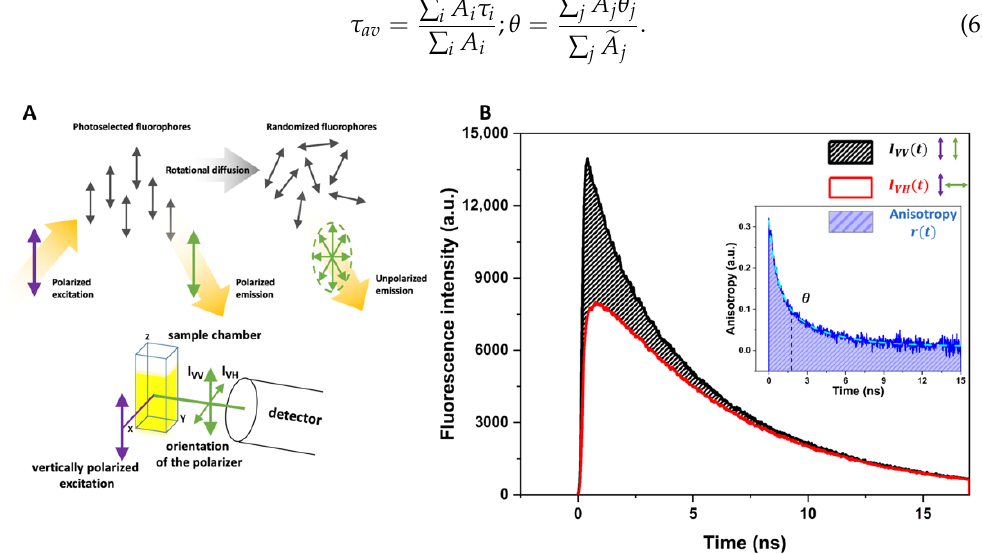
Figure 3. ( A )—physical basis of the fluorescence anisotropy. When the sample is irradiated with polarized light (e.g., vertically), the emission light will be originated mostly from those fluorophores, which dipoles correspond to the direction of the excitation polarization and therefore constitute vertically polarized emission that is measured with vertical orientation of the polarizer positioned in front of the detector (designed as I VV ). Due to the rotational diffusion of fluorophores and their mobility in the media, there will always be some components of unpolarized emission, which can be measured with orientation of the polarizer, different from vertical, for instance, at horizontal position assessing I VH . ( B )—anisotropy kinetics ( r(t) , blue graph) is formed by confronting decay curves of I VV ( t ) (black graph) and I VH ( t ) (red graph), and its relaxation time θ corresponds to rotational correlation time, which is proportional to the microviscosity. Cyan graph represents the approximation of anisotropy kinetics using double exponent decay function.